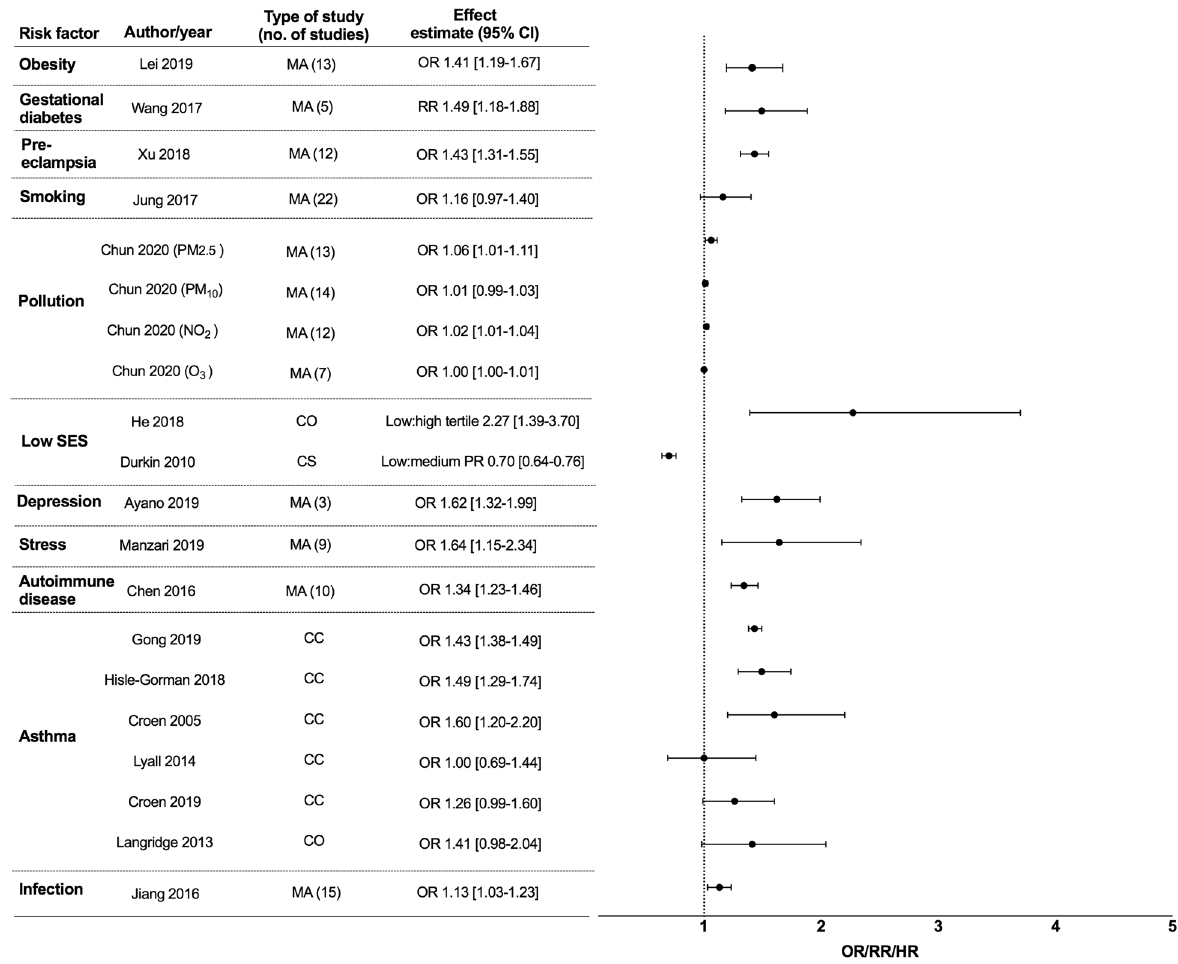
Fig. 3 Epidemiological studies of maternal in fl ammatory states and autism spectrum disorder (ASD) in offspring. Maternal in fl ammatory states included in Y-axis (with columns including author names, year of publication, type of study, number of individual studies included in meta- analysis, effect estimate with 95% con fi dence interval (CI)). Effect estimate with 95% con fi dence interval reported in X-axis. In this forest plot, we only included the largest meta-analysis that examined the association of individual maternal in fl ammatory state and ASD in offspring. For full data see supplementary Fig. 1. SES = socioeconomic status, PM 2.5 = particulate matter (particles with diameter of 2.5 micrometers or less), PM 10 = particulate matter (particles with diameter of 10 micrometers or less), NO 2 = nitrogen dioxide, O 3 = ozone, MA = meta-analysis, CC = case-control, CO = cohort, CS = cross sectional, RR = relative risk, OR = odds ratio PR = prevalence